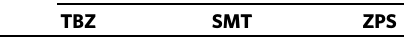
Table 3 IC 50 for the inhibition of VMAT2 (measured as FFN206 substrate uptake) by tetrabenazine (TBZ), salmeterol (SMT) and ziprasidone (ZPS) for VMAT2 wild-type and selected mutants.